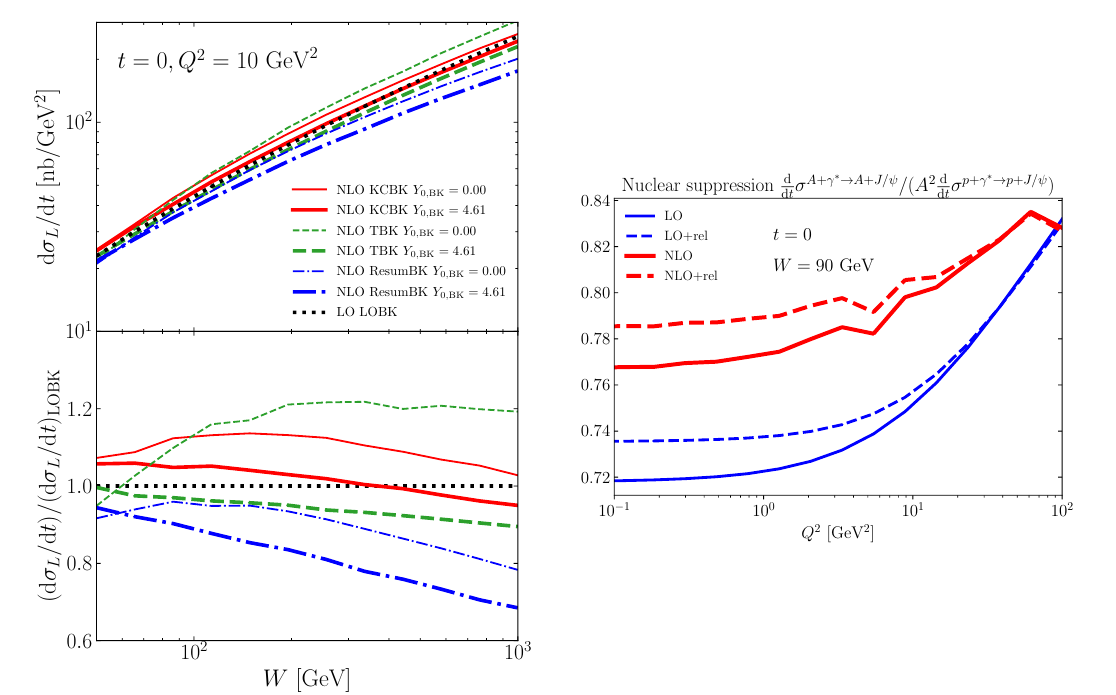
Figure 2: Left: Diffractive cross section for longitudinal J /ψ production as a function of the center-of-mass energy [ 14 ] . LO BK corresponds to a leading-order result with a leading-order dipole amplitude fit. The other curves show the NLO results with dif- ferent NLO dipole amplitude fits. In the lower plot, the curves have been normalized by the leading-order